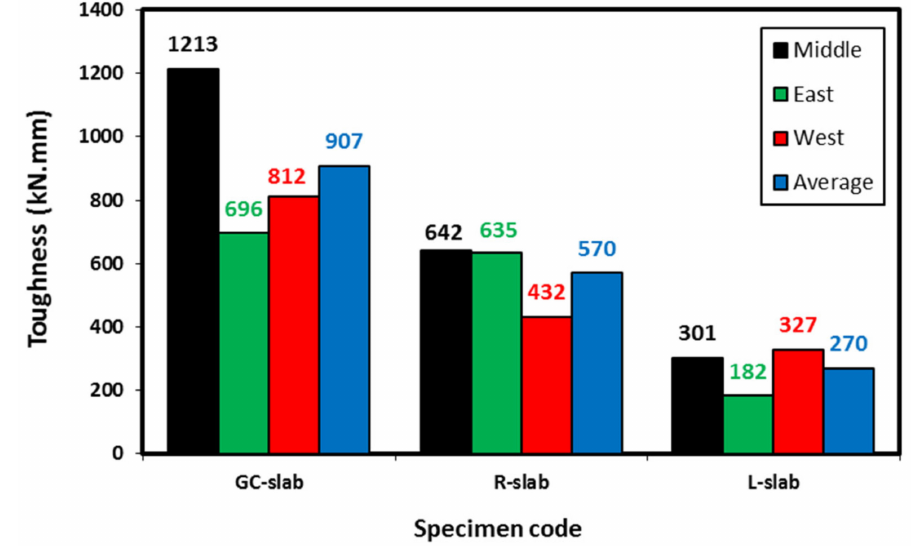
Figure 15. Toughness of the tested